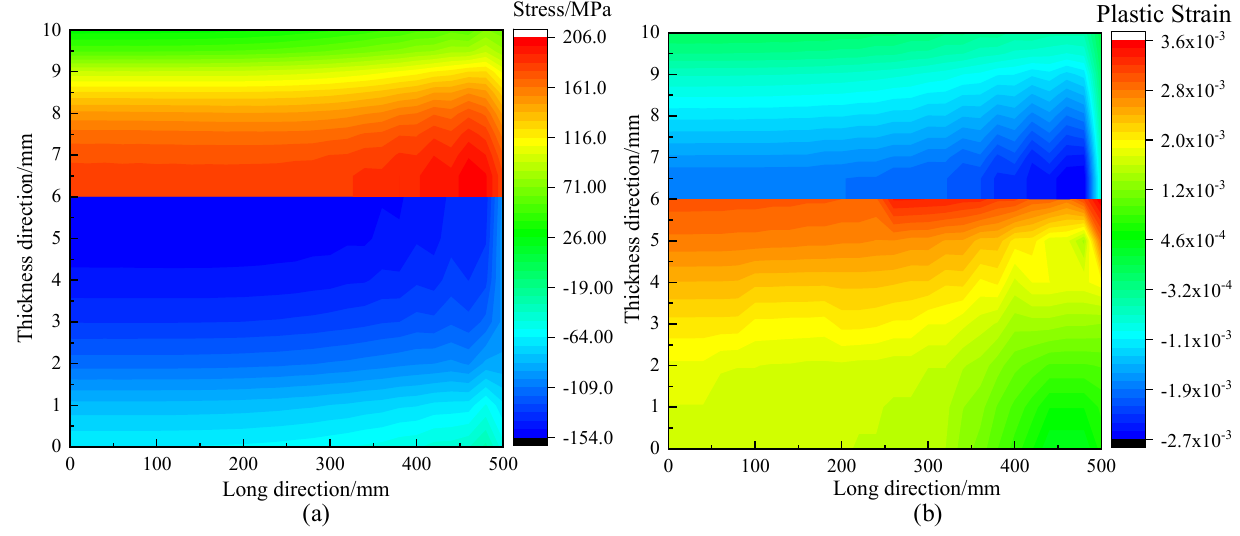
Figure 19. Distribution cloud diagram of longitudinal stress and plastic strain after slow cooling process. ( a ) Longitudinal stress. ( b ) Longitudinal plastic strain.